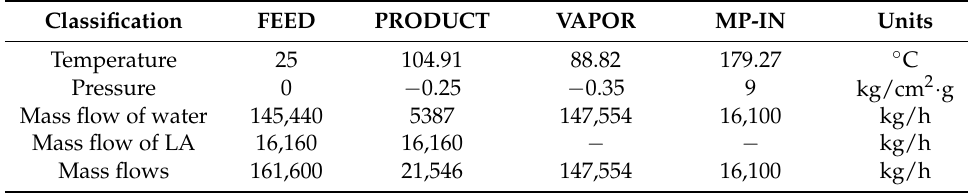
Table 6. Simulation results for the alternative evaporation process using TVR. Classification FEED PRODUCT VAPOR MP-IN Units Temperature 25 104.91 Pressure 0 − 0.25 Mass flow of water